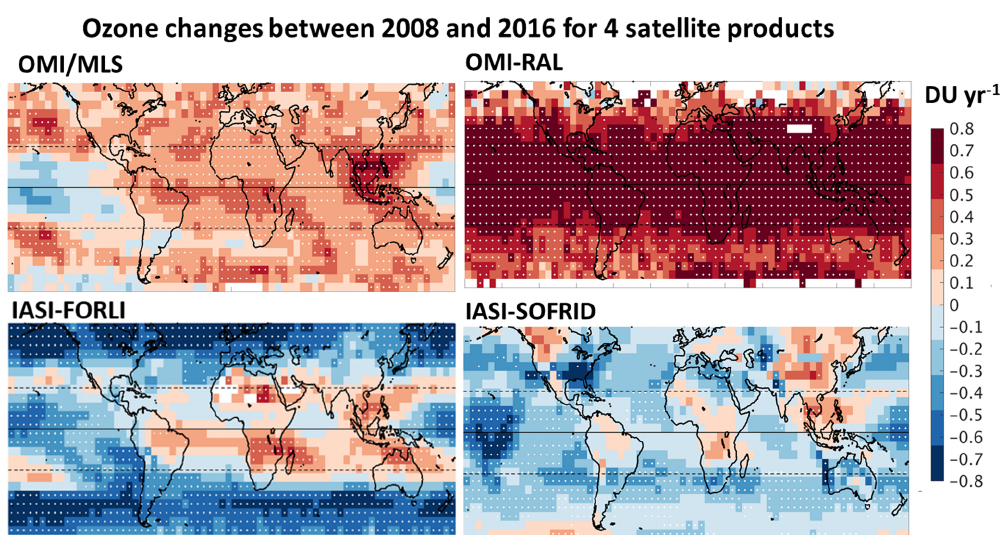
Figure B3. Global gridded ozone trends between 2008 and 2016 derived for the tropospheric columns from four satellite products (OMI/MLS, OMI-RAL, IASI-FORLI, and IASI-SOFRID) in the TOAR-I framework. The figure is an extension/update of Fig. 24 from Gaudel et al. (2018) under the CC-BY 4.0 copyright